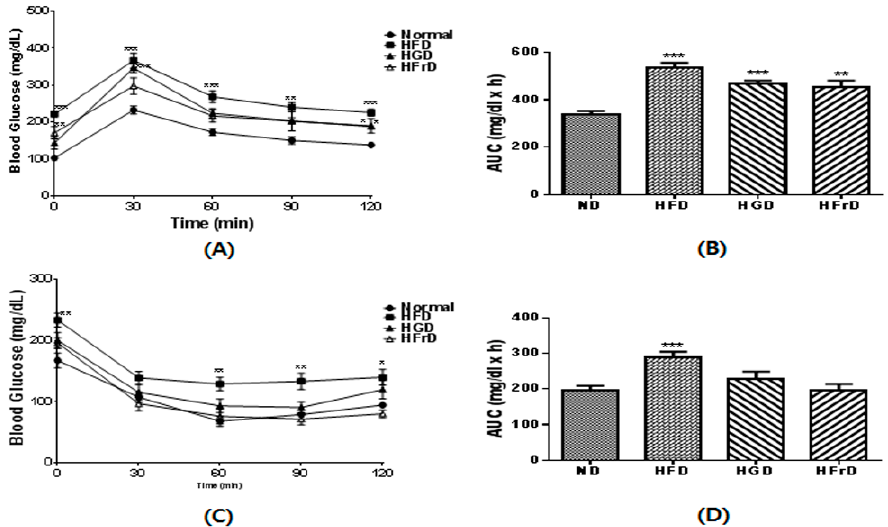
Figure 3. Glucose metabolism in HFD, HGD or HFrD fed mice. ( A ) blood glucose levels during an oral glucose tolerance tests; ( B ) area under the curve (AUC) of blood glucose levels; ( C ) blood glucose levels during an insulin tolerance tests; ( D ) AUC of blood glucose levels. Data are presented as the mean ± SEM for 9 mice per group (* p < 0.05, ** p < 0.01, and *** p < 0.001 vs.